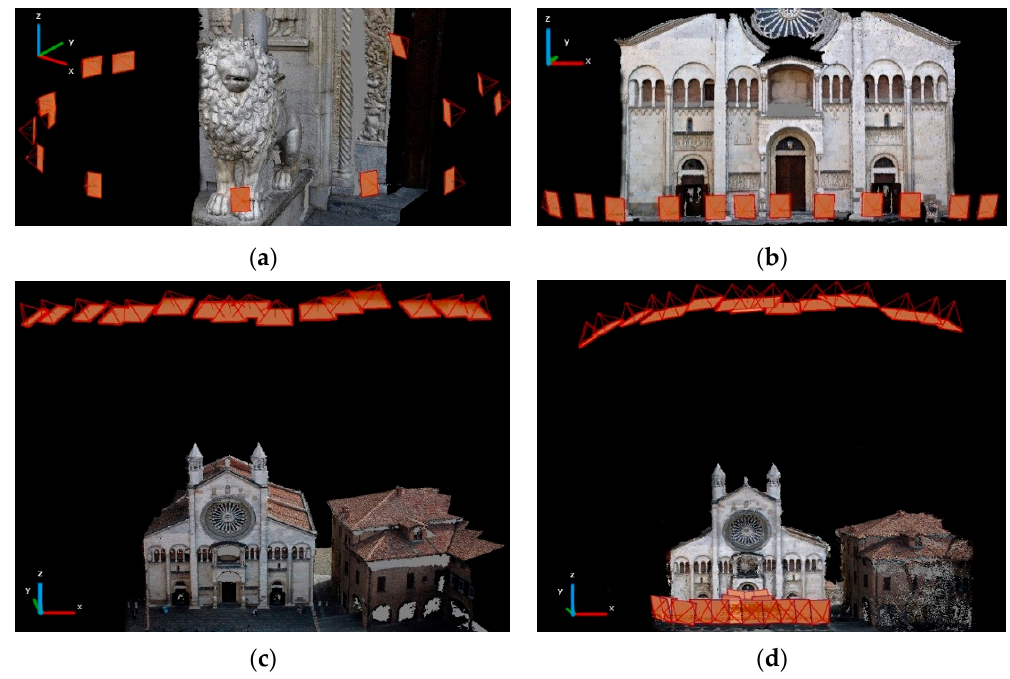
Figure 2. Several image network configurations in the Modena Cathedral subset: terrestrial-convergent ( a ), terrestrial-parallel ( b ), unmanned aerial vehicle (UAV) ( c ) and terrestrial and UAV combined ( d ).